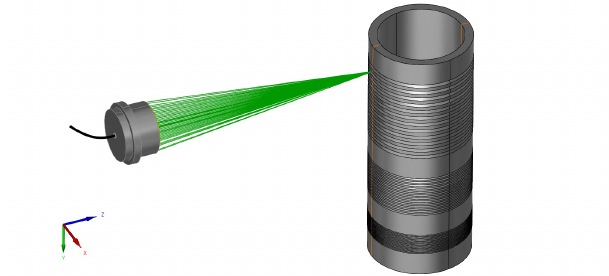
Fig. 10. 3D view of the CIVA